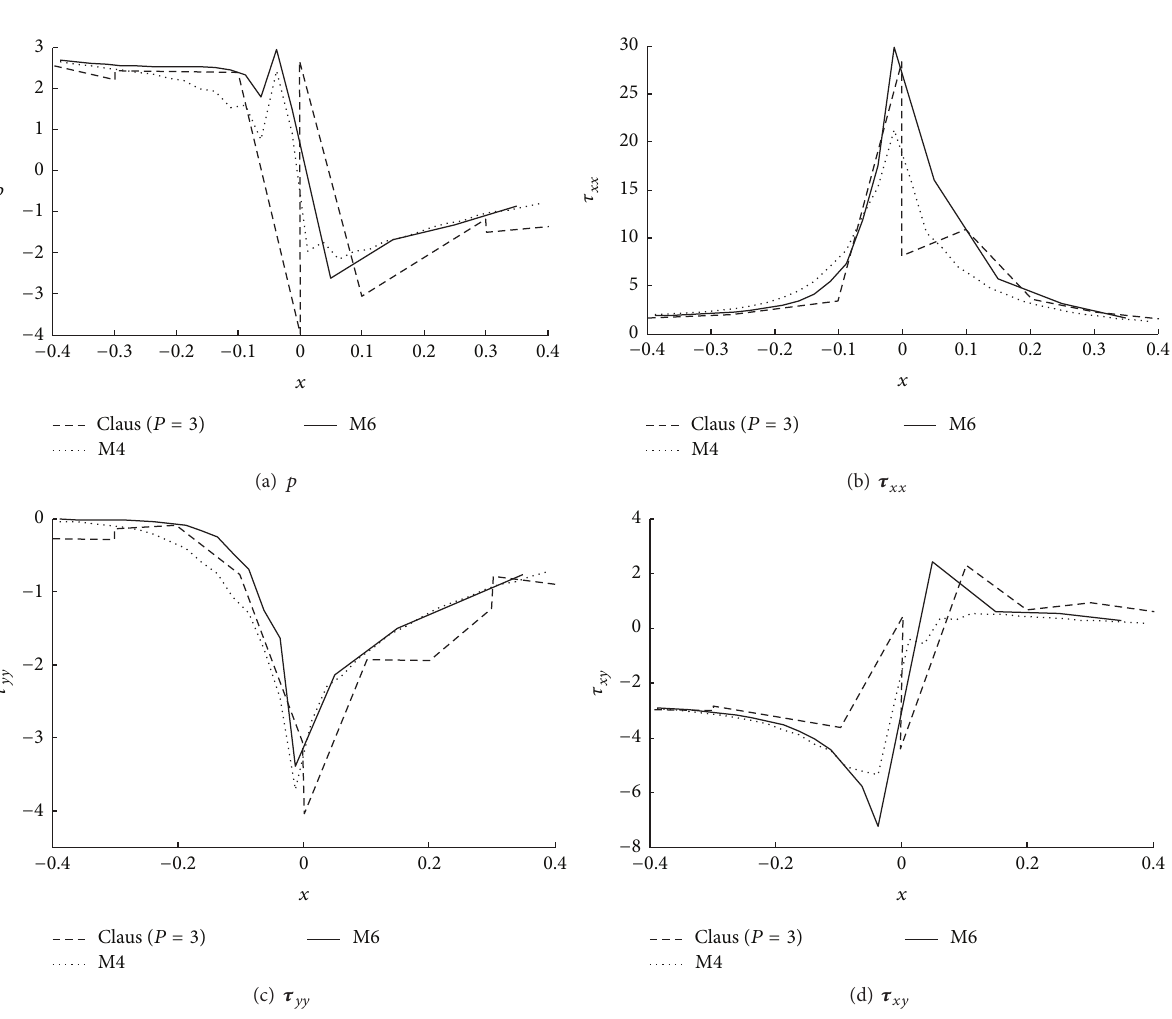
Figure 2: Pressure and components of polymer stress near the singularity at Wi = 0.1 .